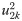
Color plot of the normalized squared components u2k2 of the Fiedler mode on generator buses in the European and ERCOT grids.Labeled buses correspond to labeled symbols in Figs 9 and 10.